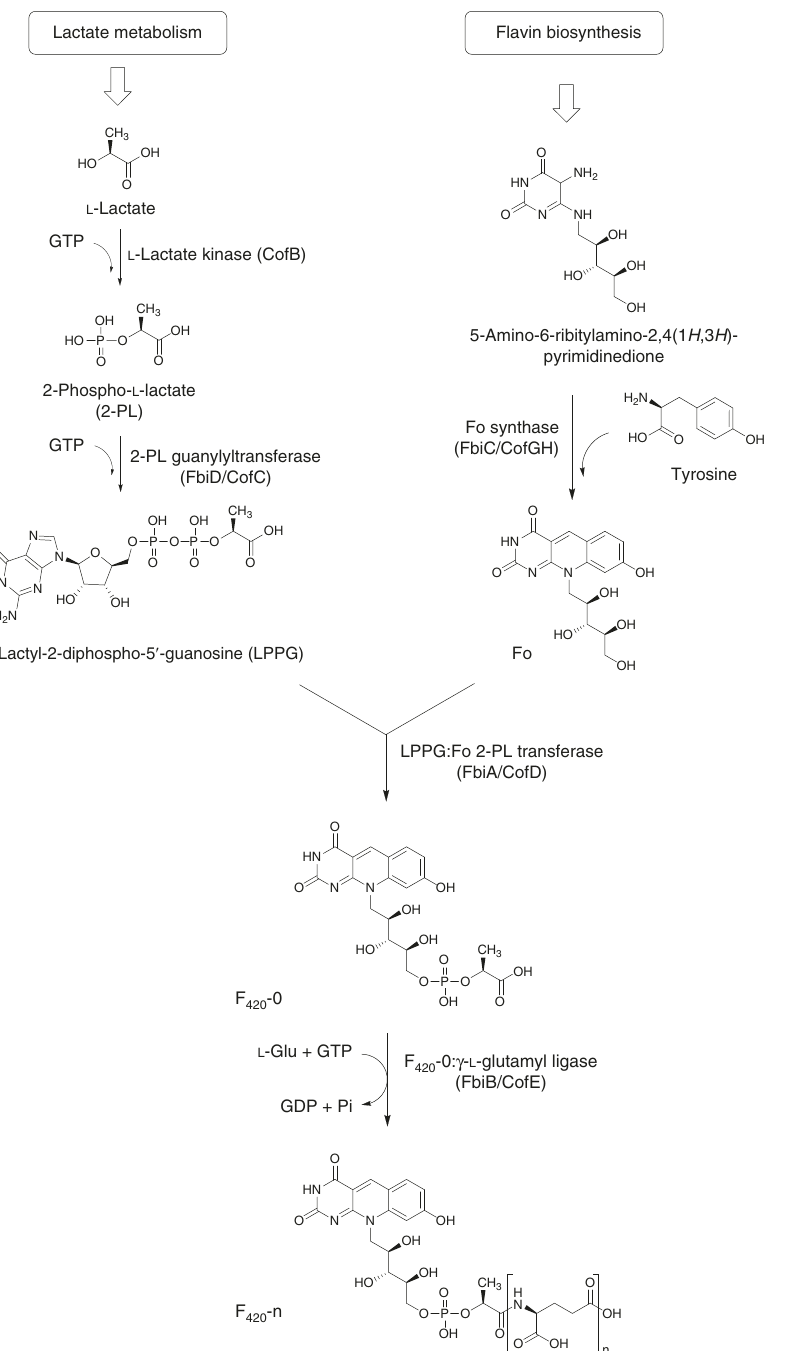
Fig. 1 The currently accepted bacterial F 420 biosynthesis pathway. The pathway is composed of two branches. In the fi rst branch tyrosine is condensed with the fl avin biosynthesis intermediate 5-amino-6-ribitylamino-2,4-(1 H ,3 H )-pyrimidinedione by FbiC/CofGH to produce the ribo fl avin level chromophore Fo. In the second branch, L -lactic acid is phosphorylated in a guanosine-5 ʹ -triphosphate (GTP)-dependent manner by the hypothetical L -lactate kinase CofB to produce 2-phospho- L -lactate (2-PL). This compound is subsequently guanylylated by FbiD/CofC to produce the unstable intermediate L -lactyl-2- diphospho-5 ʹ -guanosine (LPPG). The two branches merge as the 2-phospho- L -lactyl moiety of LPPG is transferred to Fo through the action of FbiA/CofD to produce F 420 -0. Mature F 420 is then produced through glutamylation of F 420 -0 by FbiB/CofE. “ Fbi ” refers to bacterial proteins, whereas “ Cof ” represents archaeal